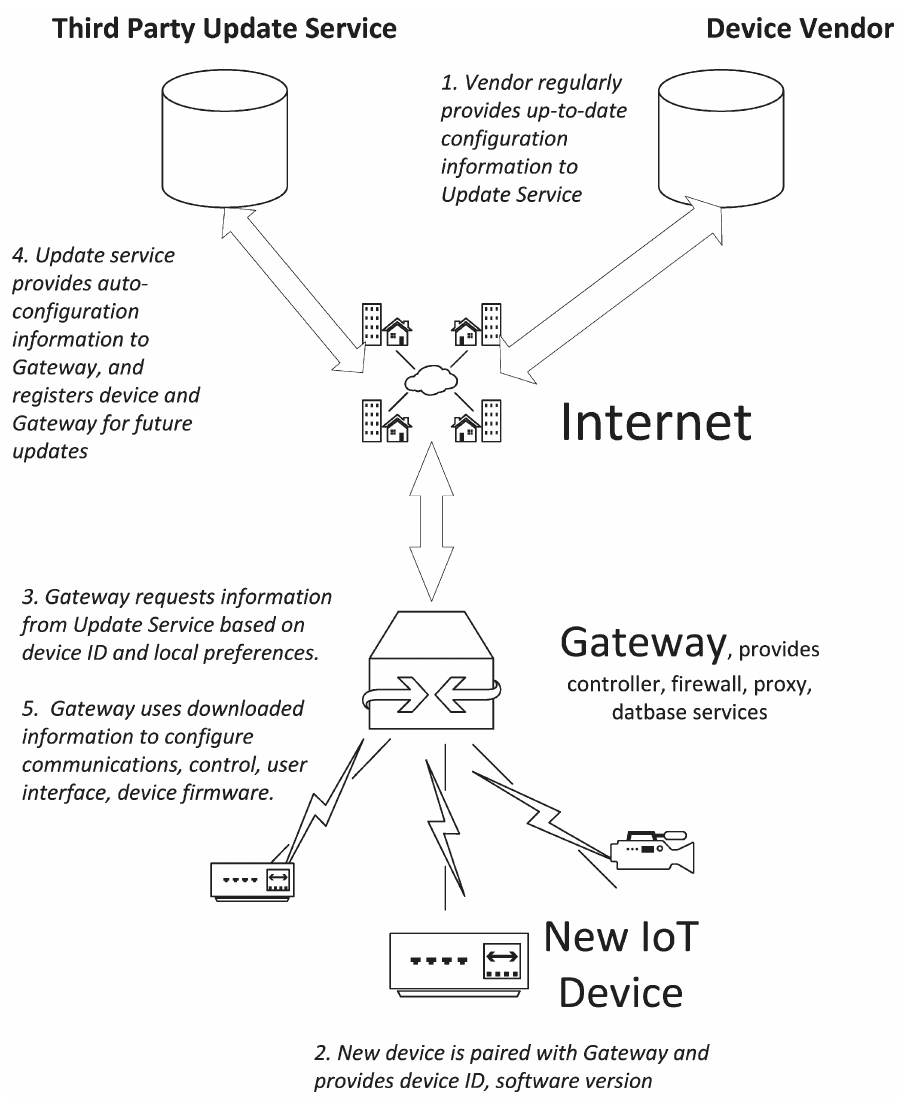
Figure 3. Auto-configuration architecture.